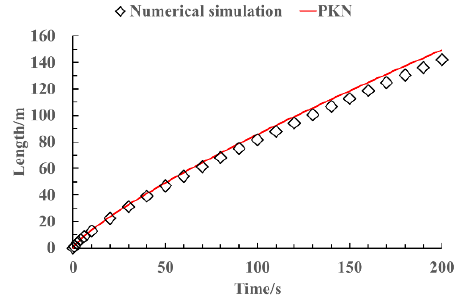
Figure 2. Results of fracture length.